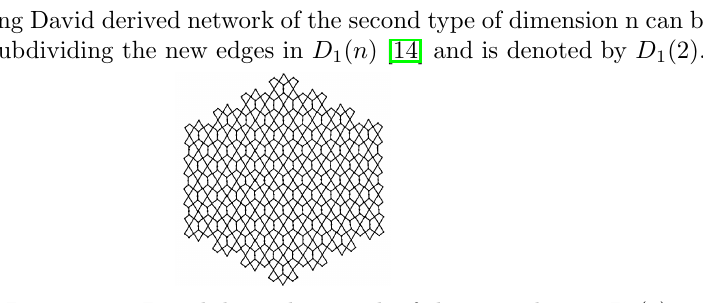
Figure 2. Dominating David derived network of the second type D 2 (2)